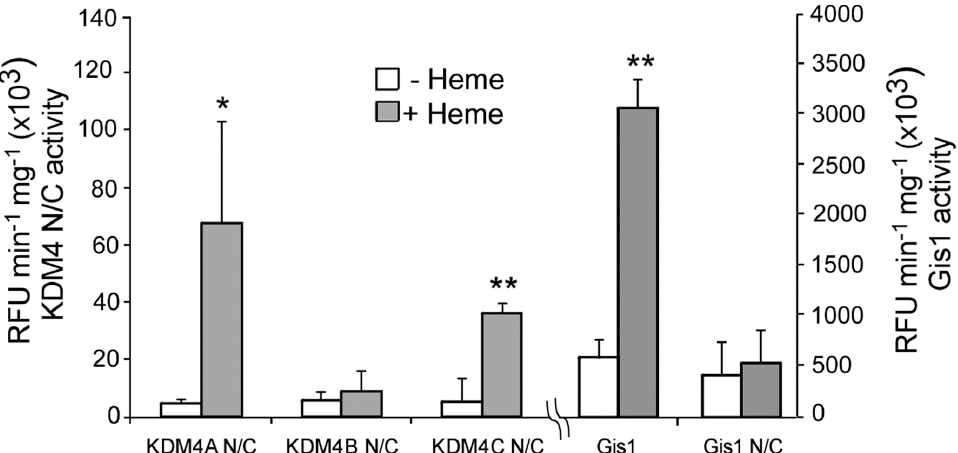
Figure 4. Heme stimulates histone demethylase activities of KDM4A and C, but not KDM4B.